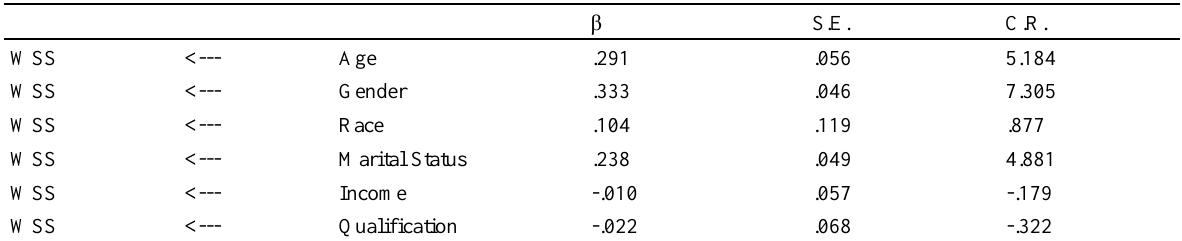
Table 1: Standardized beta coefficients of the estimates of the strengths of the causal paths of the variables in the model β S.E. WSS <--- Age <--- Gender .333 <--- Race .104 <--- Marital Status WSS <--- Income -.010 WSS <--- Qualification